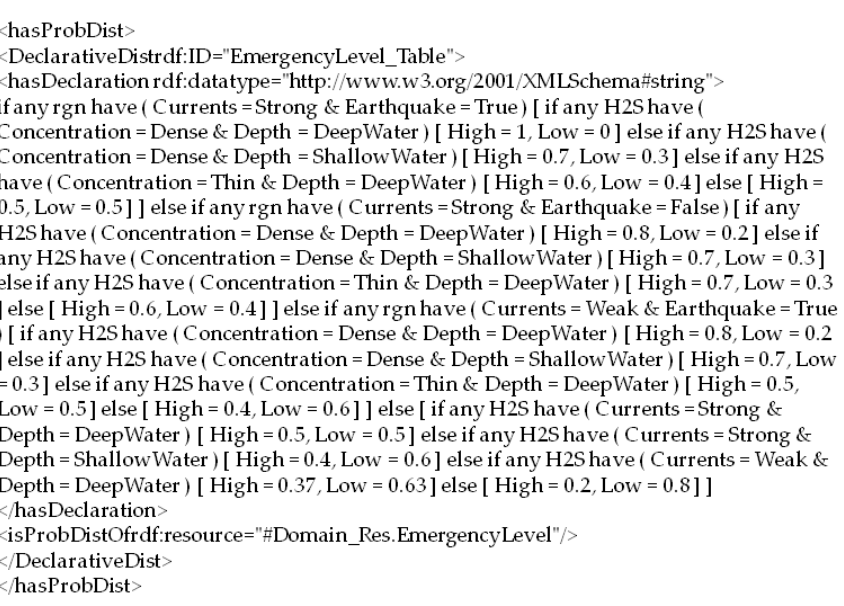
Figure 12. The OWL annotation for the emergency level probability distribution.